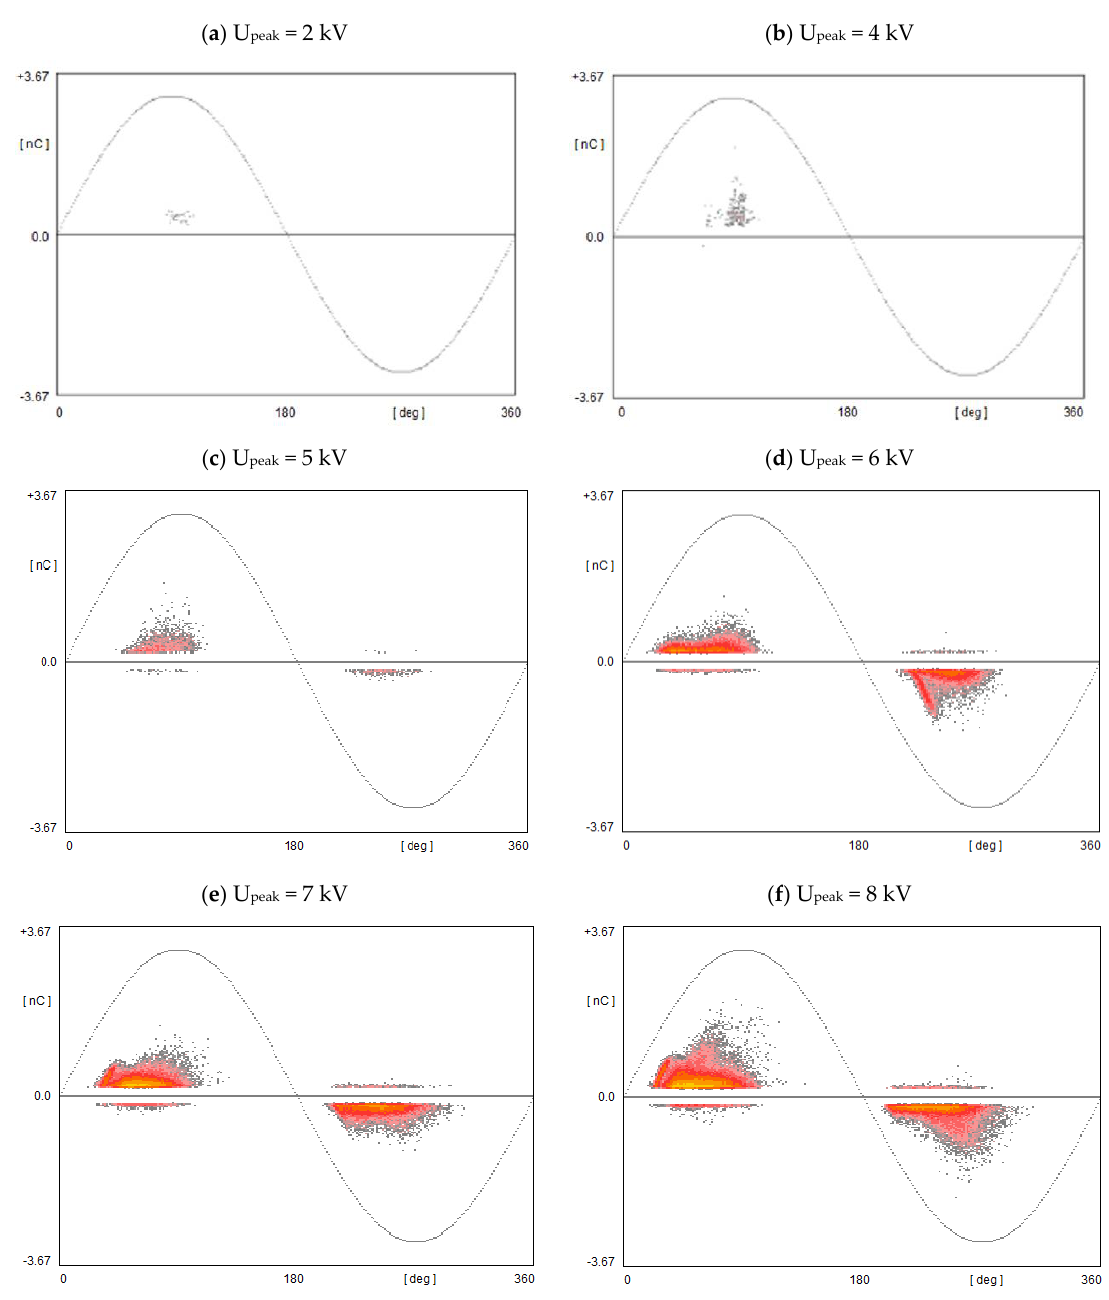
Figure 4. PRPD patterns at mixed DC 10 kV and additional 50 Hz AC content with a magnitude U peak : ( a ) 2 kV, ( b ) 4 kV, ( c ) 5 kV, ( d ) 6 kV, ( e ) 7 kV, ( f ) 8